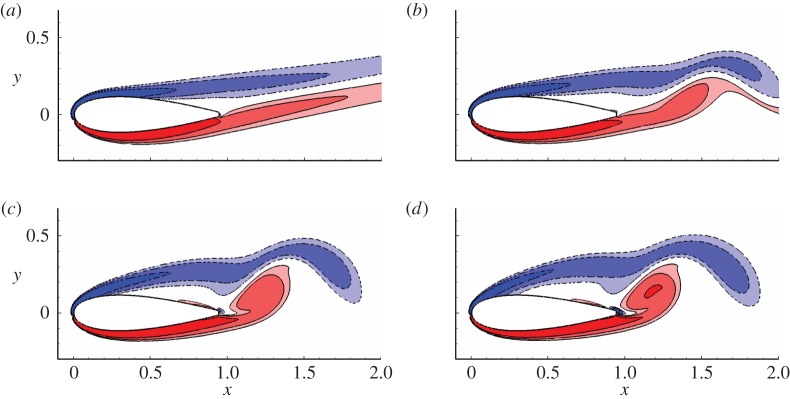
Contours of vorticity at t=20, Re=1000, α=10°, ω=0 and scale factor (a) b=−0.05, (b) b=−0.02, (c) b=0.02 and (d) b=0.05. The control is scaled from the sensitivity with respect to drag. (Online version in colour.)